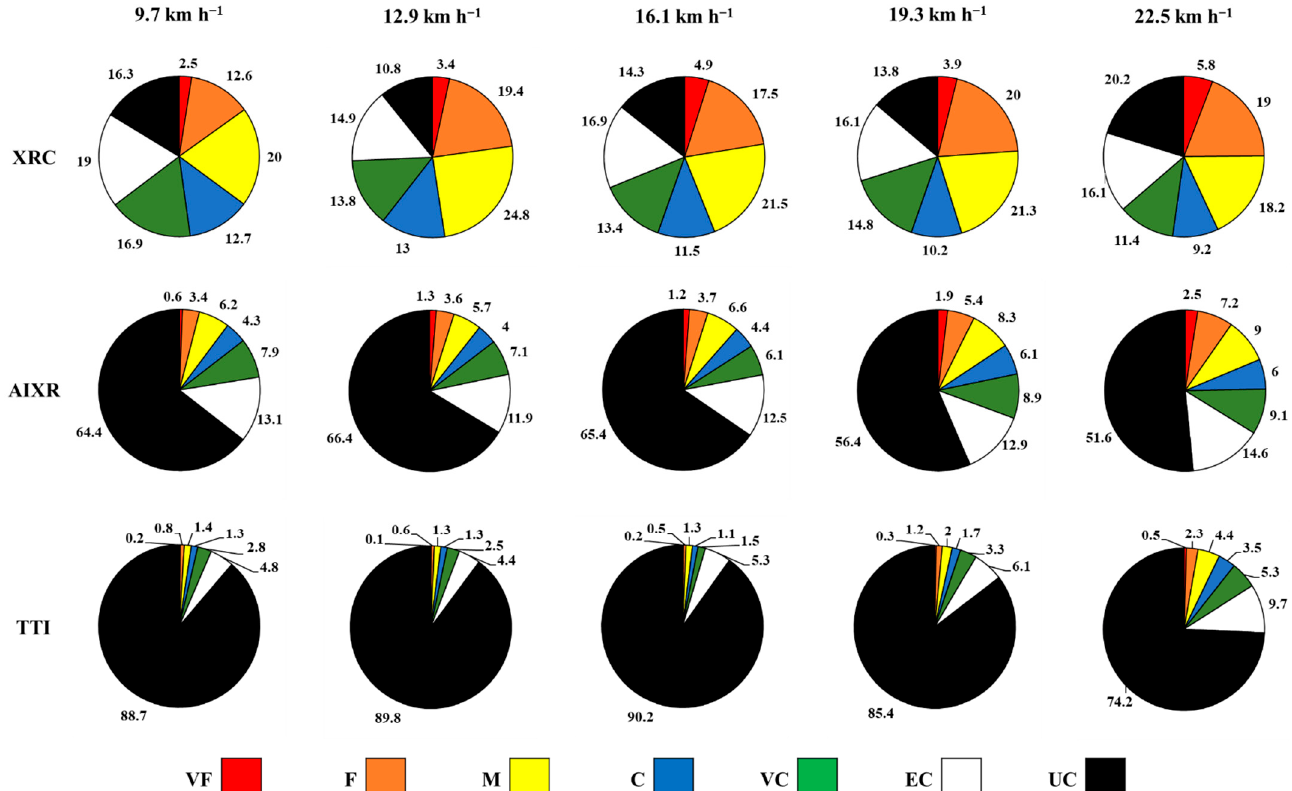
Figure 4. Spray quality (droplet size classification based on volume median diameter) for XRC, AIXR, and TTI nozzles at varying ground speeds for CNS. CNS represents the sprayer without a rate controller while XRC, AIXR, and TTI represent TeeJet ® extended range, air induction extended range, and turbo-teejet induction nozzle types, respectively, used in this study. VF, F, M, C, VC, EC, and UC represents the very fine, fine, medium, coarse, very coarse, extremely coarse, and ultra-coarse spray droplets, respectively, as defined by the ASABE S572.3 [16]. Table 8. Influence of ground speed on D 0.1 , D 0.5 , and D 0.9 by nozzle type for SRC. D 0.1 , D 0.5 , and D 0.9 are the droplet diameters ( µ m) where 10%, 50%, and 90%, respectively, of the spray volume is contained in the spray droplets smaller than this value. SRC represents the sprayer equipped with a rate controller used in this